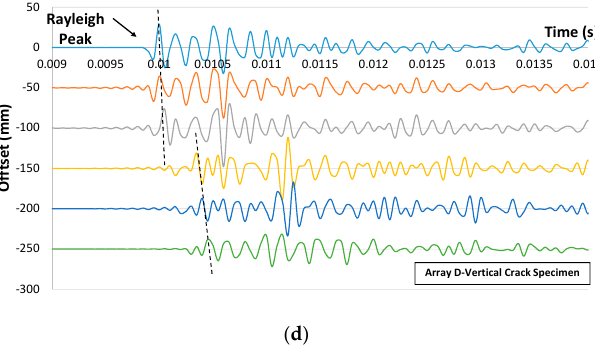
Figure 11. Time domain traces collected on array A for ( a ) control specimen and ( b ) specimen with vertical crack and ( c ) on array B for latter concrete specimen and ( d ) on array D for the specimen with the crack.